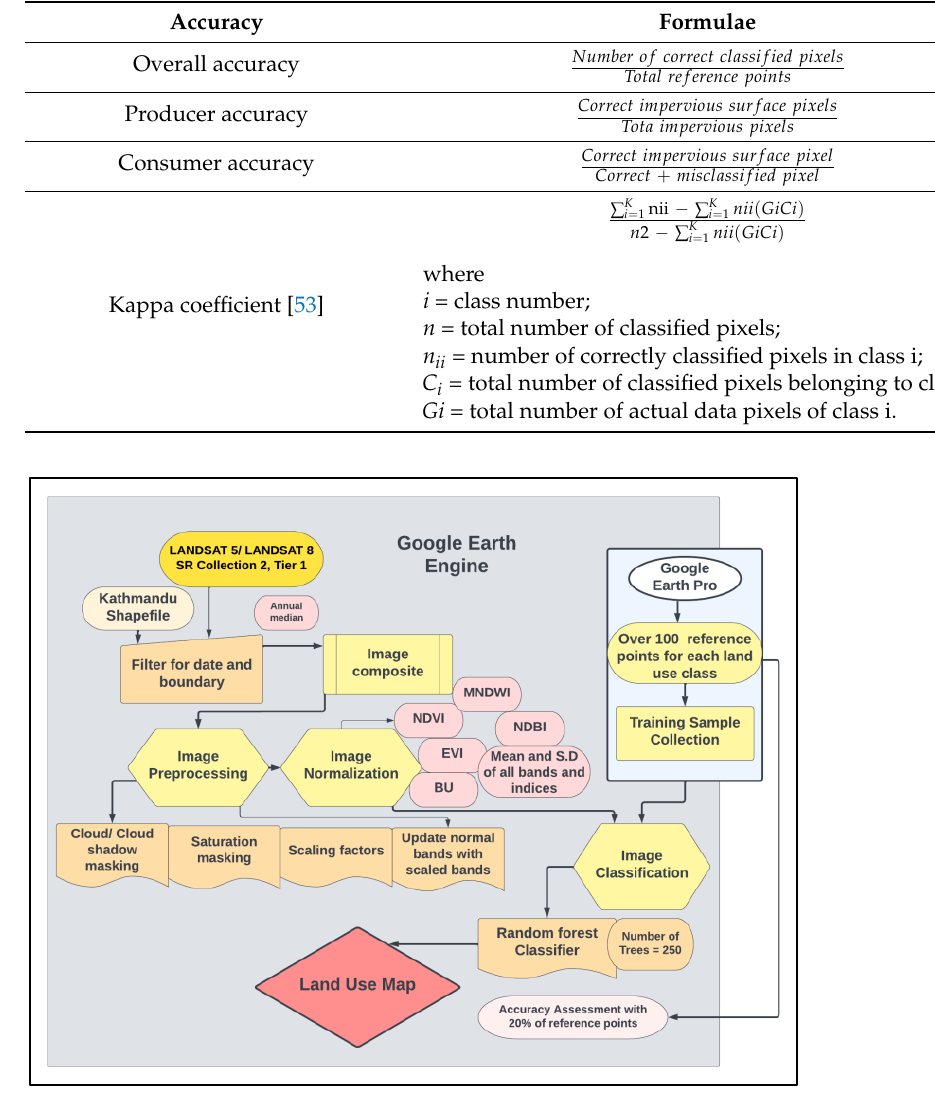
Figure 2. Flow diagram showing methodology.